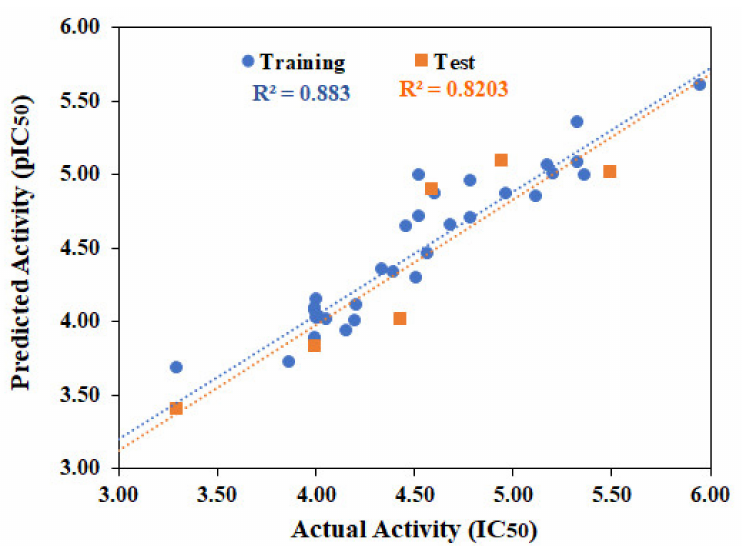
Figure 1. Graphical presentation of correlation between actual and predicted α -glucosidase in- hibitory activities of training and test set compounds. R 2 of training and test set are 0.883 and 0.820,